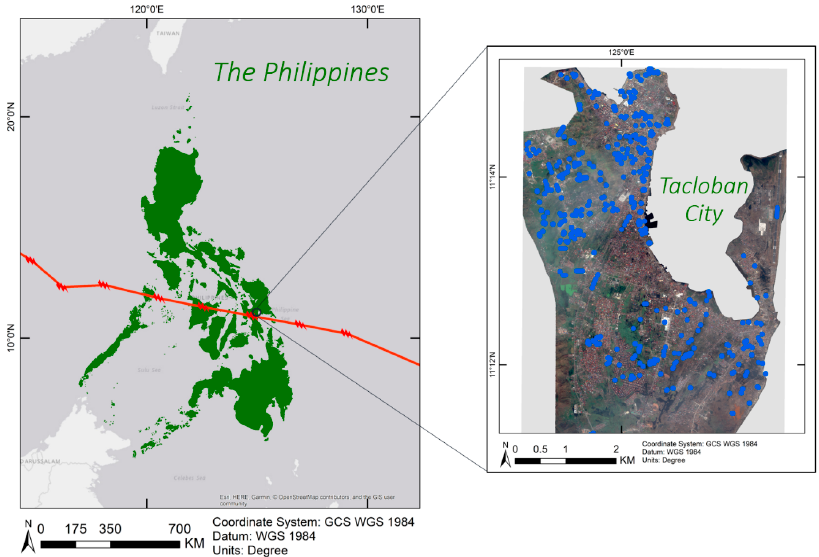
Table 1. Description of data used.